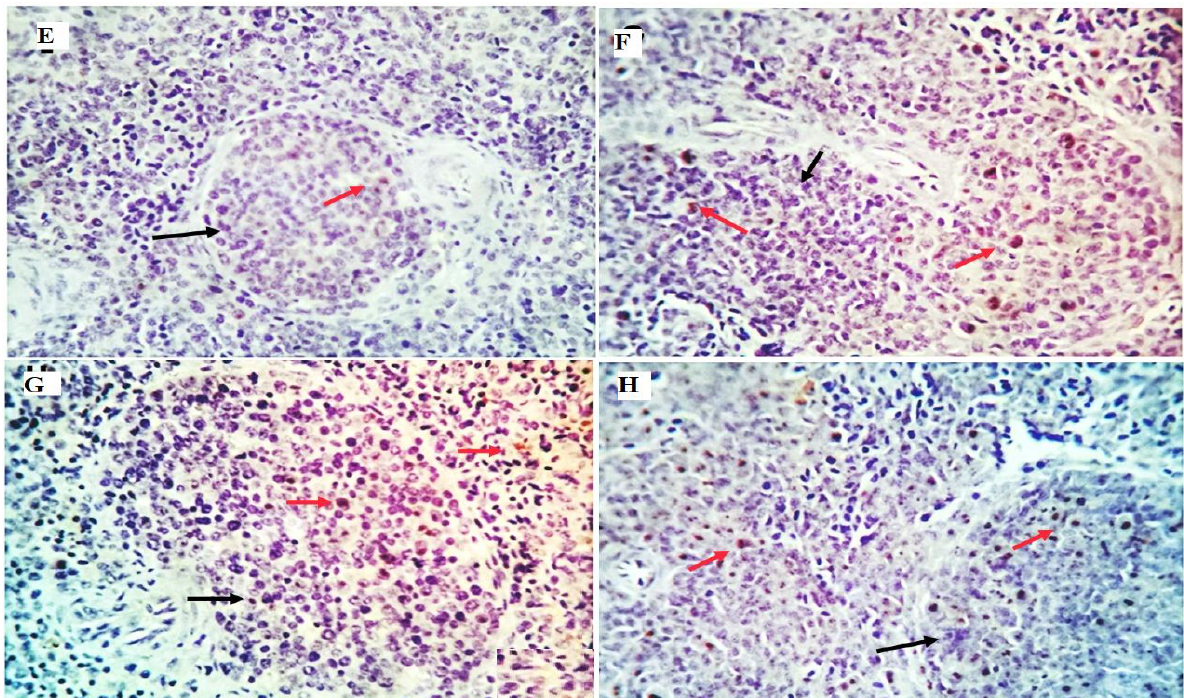
Figure 5. Immunostained positive TGF- β cells (red arrows) in the spleen of different experimental chicken groups ( E ): 0.21, ( F ): 0.82, ( G ): 1.06, and ( H ): 2.8% for LEO0, LEO200, LEO400, and LEO600 groups, respectively.